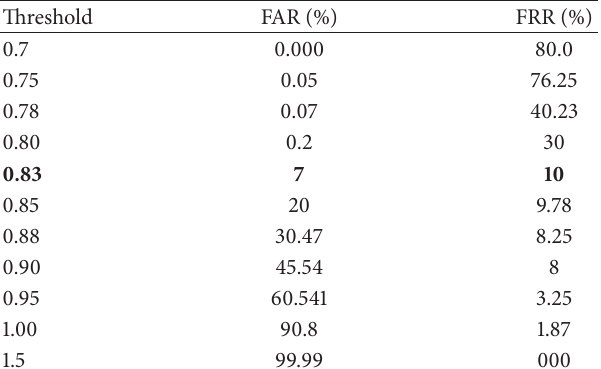
Table 6: Best FAR, FRR, and corresponding threshold for Experiment